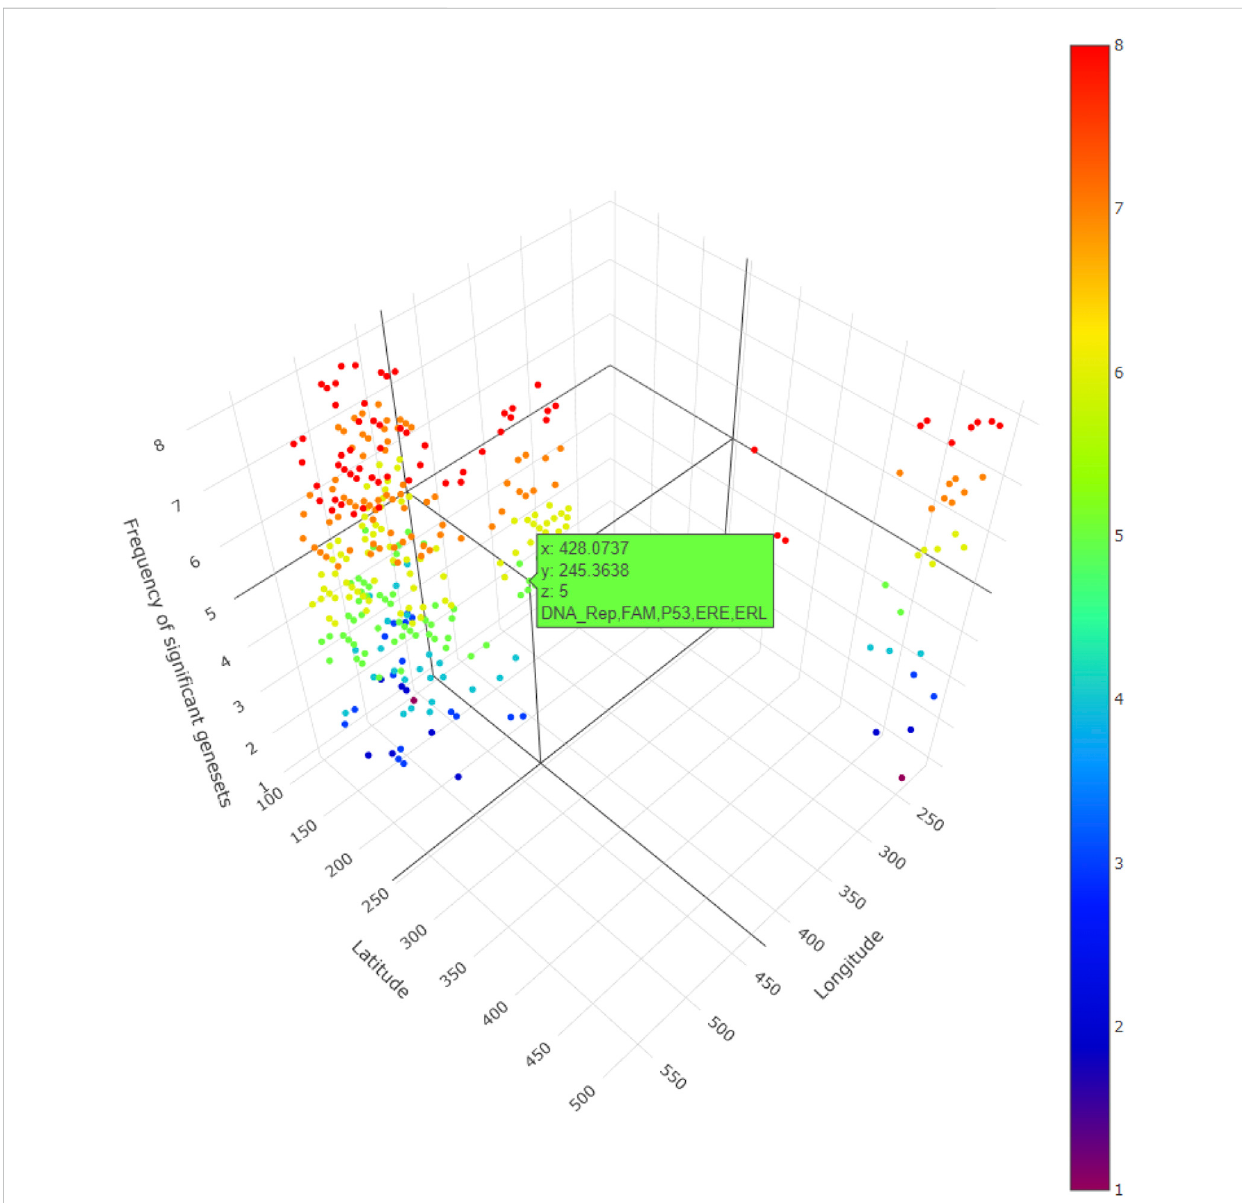
FIGURE 3 A snapshot of the 3D plot for COL11A1 at high CAF level. The number of signi fi cant gene-sets are shown in 8 colors (based on 8 gene-sets). The interactive plots can be accessed at: https://mortezahaji.github.io/GWLCT-Project/.